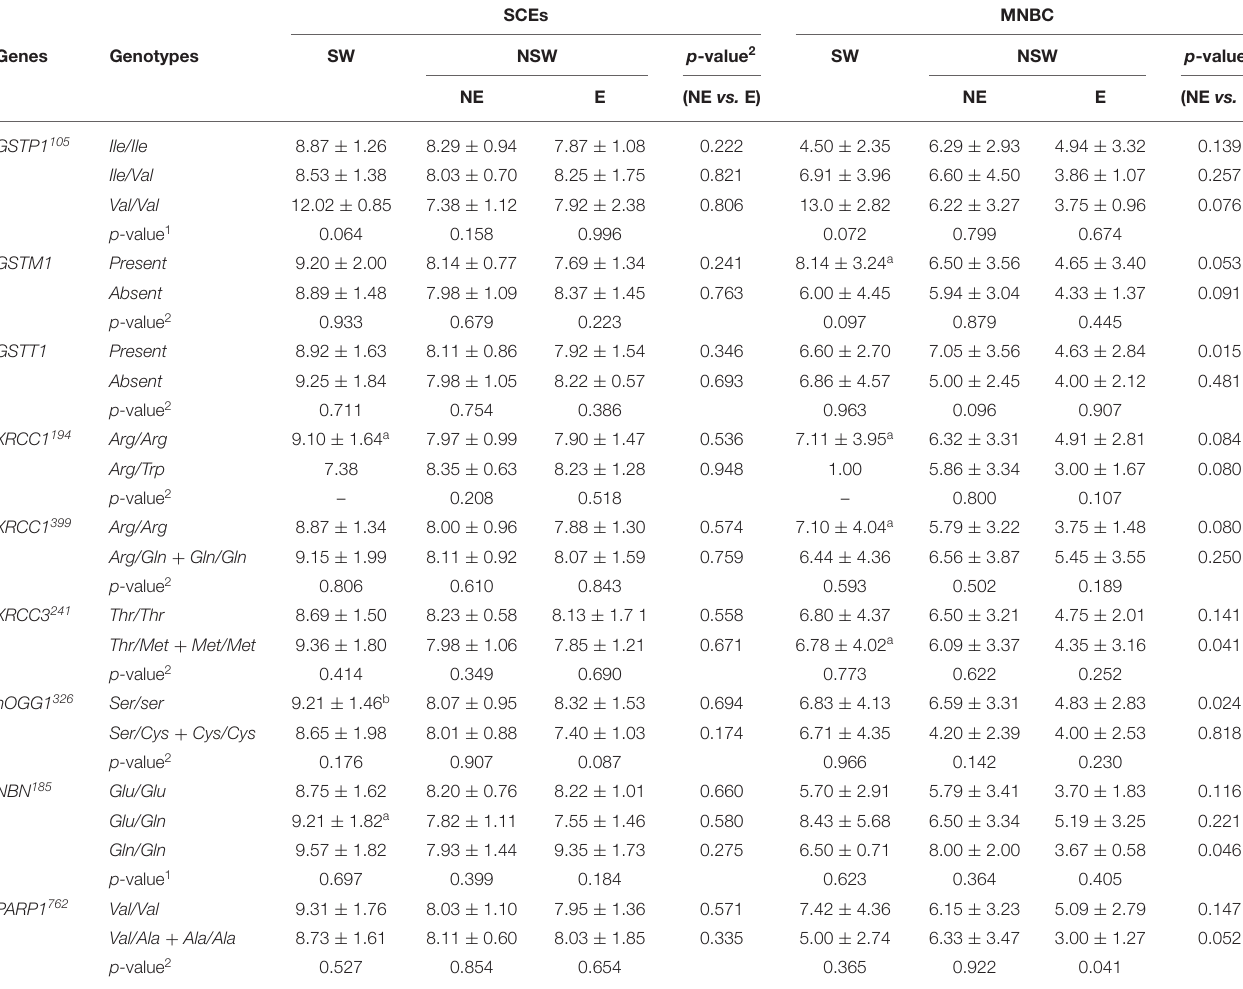
TABLE 5 | Mean ( ± SD) frequencies of SCEs and MNBC in PBL in the studied groups stratified by genotypes.